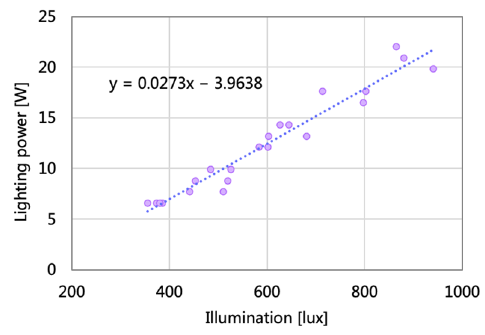
Figure 7. Tendency of illumination and energy consumption.